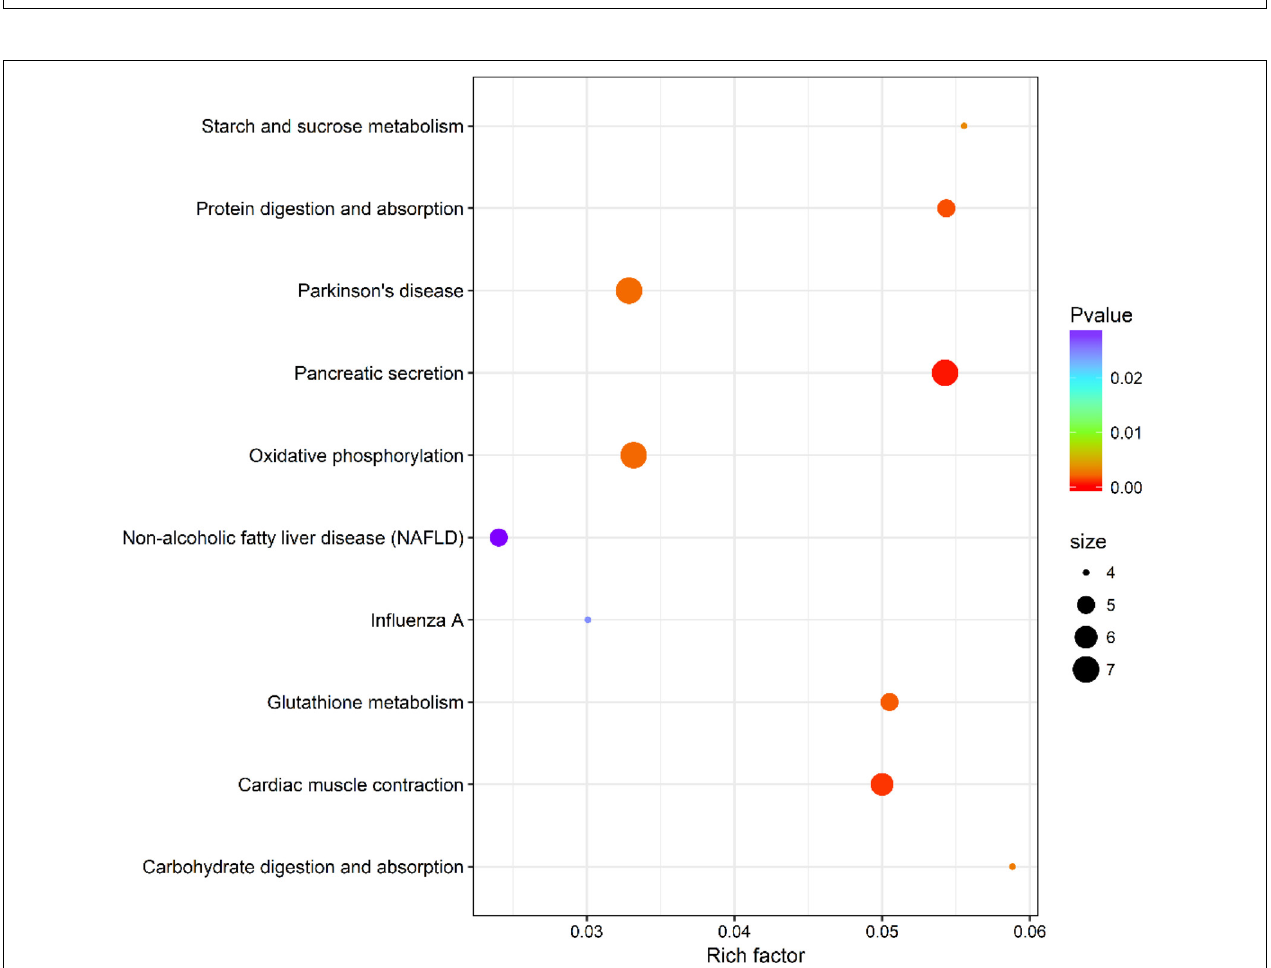
FIGURE 5 | Top 10 pathways enrichment statistics between RL and YL at control temperature.